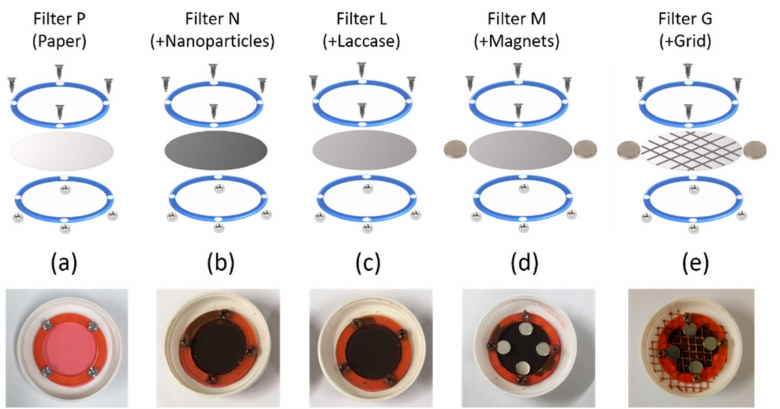
Figure 7. Filters design. The evaluated filters were: ( a ) Filter P: filter paper without modification, ( b ) Filter N: Filter P with magnetite, ( c ) Filter L: Filter N with Laccase-magnetite, ( d ) Filter M: Filter L with magnets and I Filter G: Filter M with metal mesh ( e